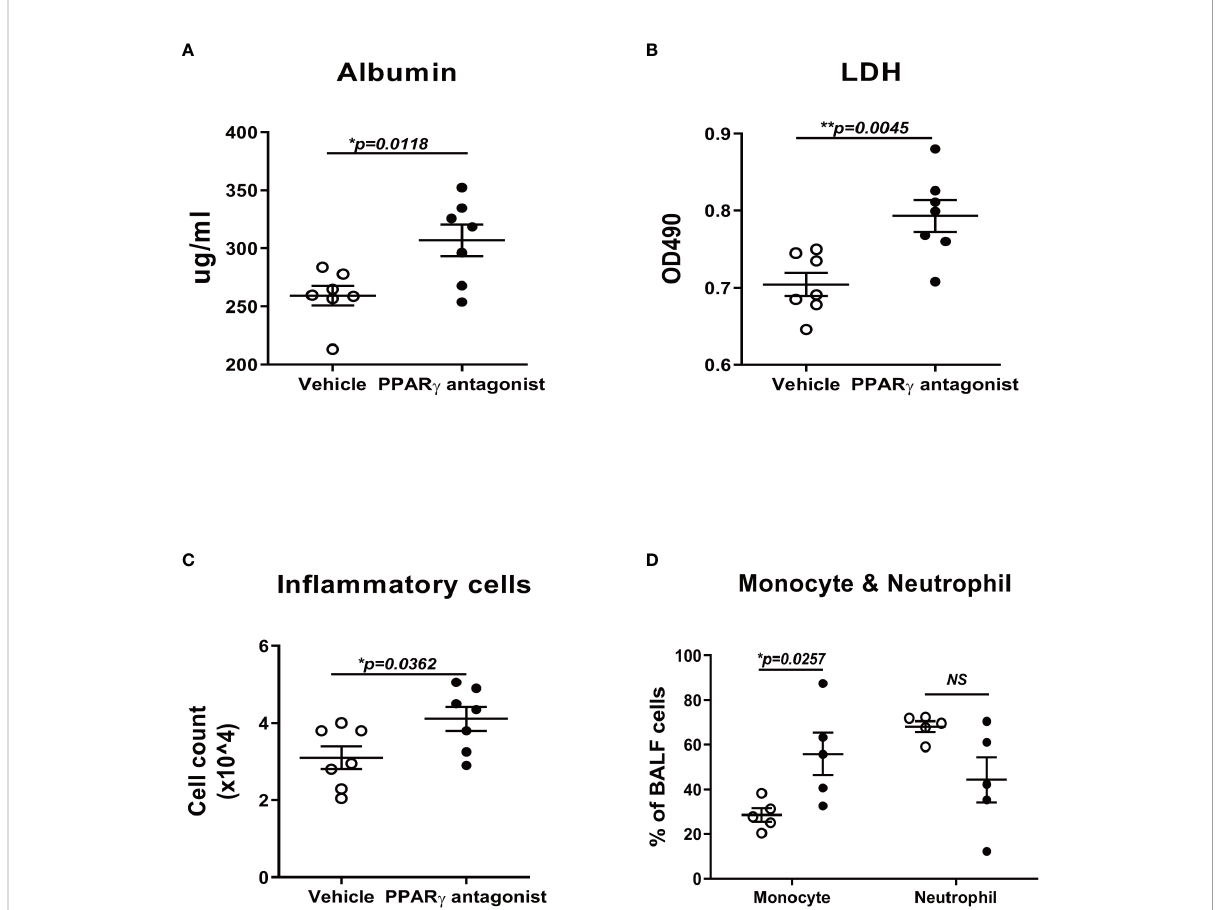
FIGURE 6 PPAR g antagonist promotes in fl uenza-induced lung injury and in fl ammation. C57B/6 mice were treated with PPAR g antagonist, T0070907, prior to in fl uenza infection and evaluated in fl ammatory cell differentiation in bronchoalveolar lavage fl uid (BALF) and acute lung injury. Compared to the vehicle control-treated group, T0070907 treated mice displayed elevated albumin (A) , LDH (B) , TNF a (C) , and total cell number (D) . Unpaired t test was applied for the statistical analysis. ns means no signi fi cance. *p < 0.05, **p <